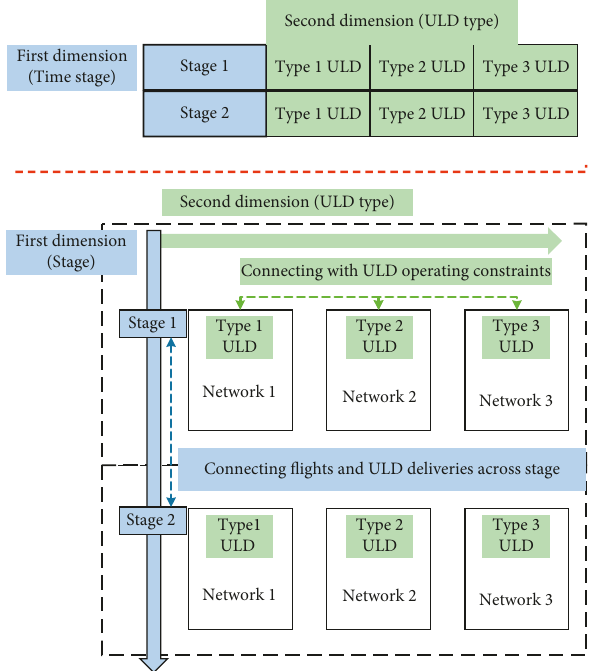
Figure 5: An illustration of the two dimensions in the